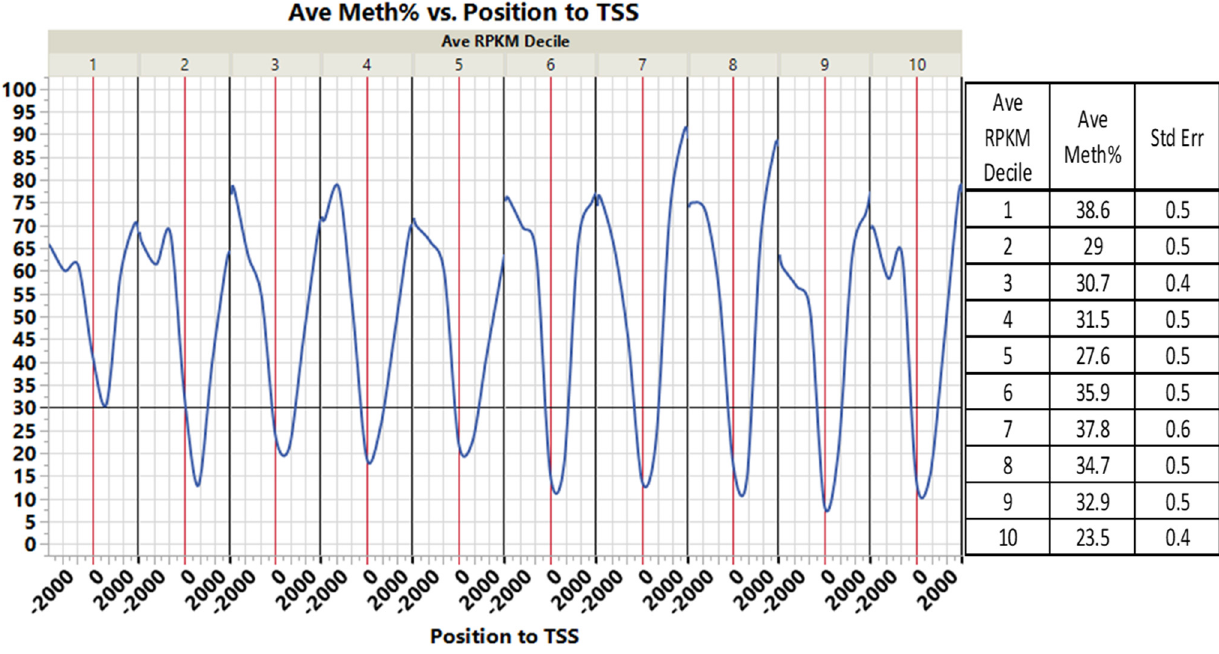
Figure 7. DNA methylation versus gene expression deciles. There is an inverse relationship between gene expression deciles (based on an increasing ranking of expression measured RPKM) and gene methylation average percentages of CGI within − 2 kb and +2 kb of TSS. The table shows the average gene methylation percentages and StdErr for each gene expression decile.